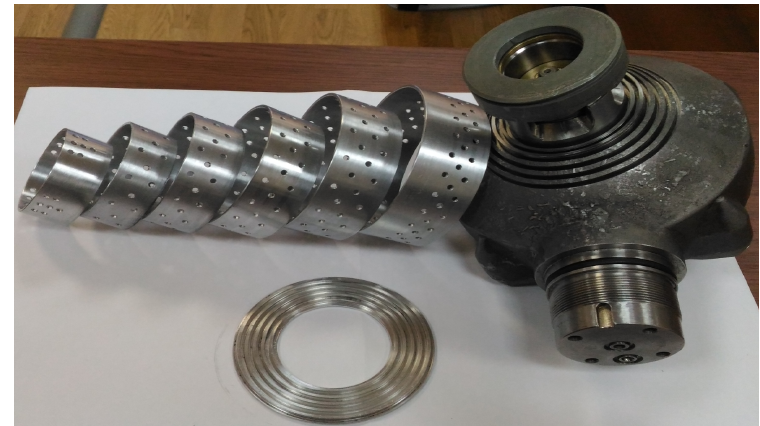
Figure A2. Muffler block disassembled.